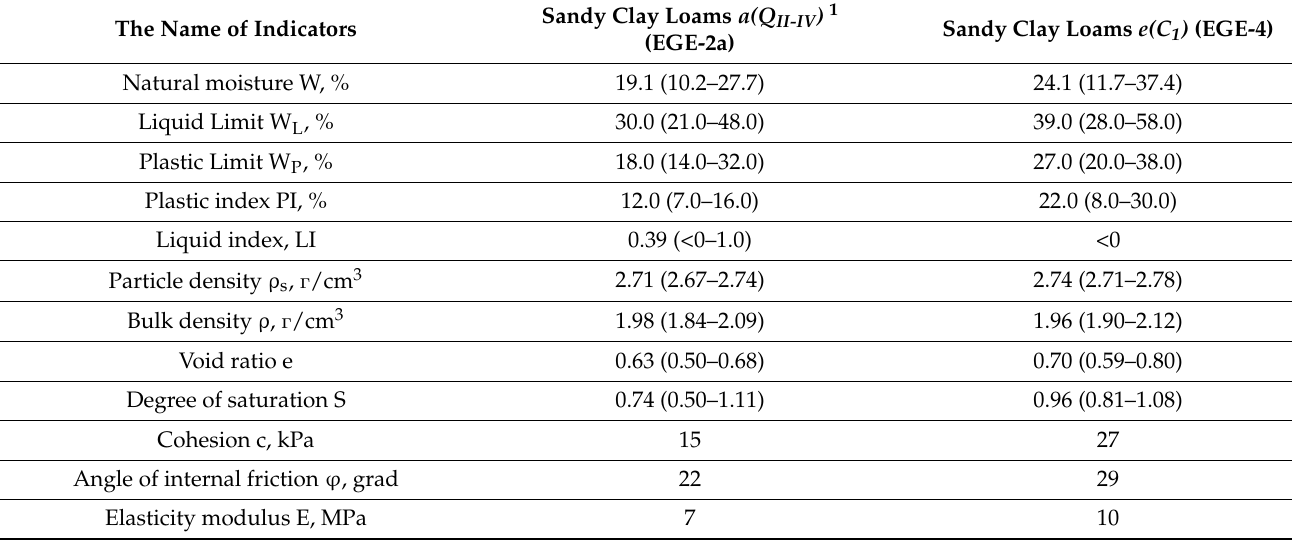
Table 3. Physical and mechanical characteristics of the soil layers in Zone